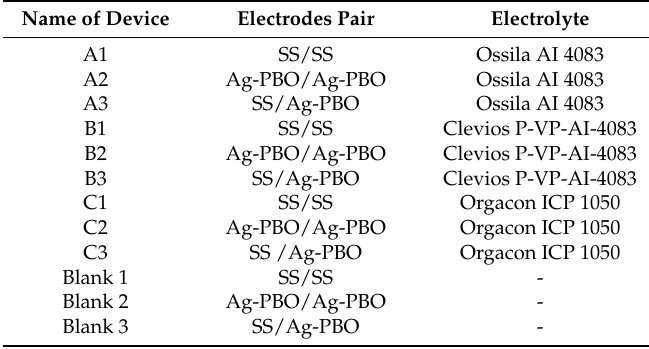
Figure 2. ( a ) Example of the actual textile energy device used in this experiment and ( b ) Schematic design of the textile energy storage device. Note that the electrodes used in the above device were a coated polybenzoxazole (Ag-PBO) and Ag-PBO/Ag-PBO, were also used. Table 1. Variation set up of the